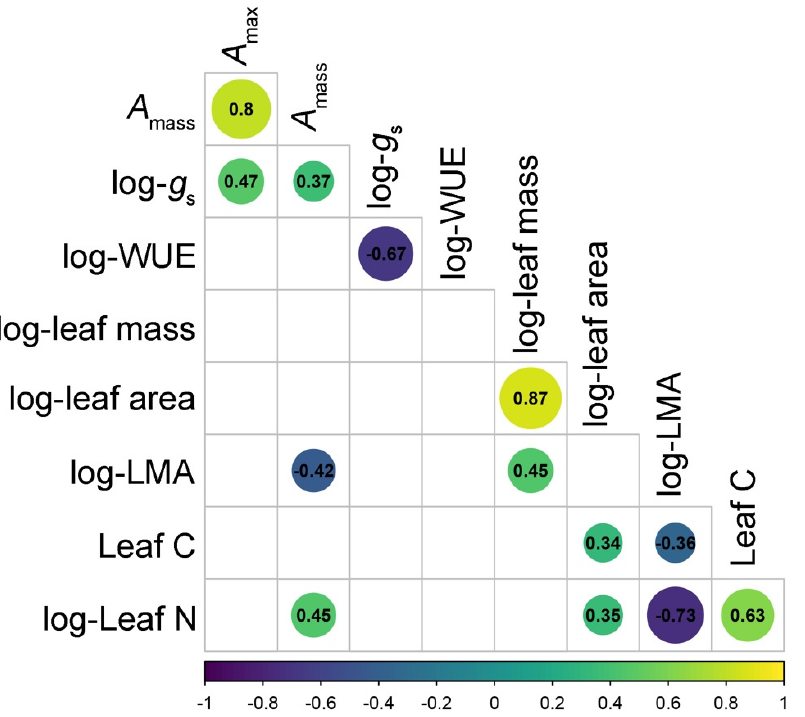
Figure 3. Pearson correlation tests analyzing the relationships between nine leaf traits measured across five wine grape varieties in Southern Ontario, Canada. Shades of circles correspond to Pearson correlation coefficients for each test which are presented numerically within the circles. Sample sizes for each correlation test were n = 90 leaves, and only statistically significant trait correlations represented by circles/correlation coefficients (where p ≤ 0.05) are presented here. A full trait correlation matrix is presented in Table S1. Trait abbreviations are as follows: A max : light saturated maximum photosynthetic rate on a per-unit leaf area basis; A mass : light saturated maximum photosynthetic rate on a per-unit leaf mass basis; g s : stomatal conductance; WUE: instantaneous water use efficiency; LMA: leaf mass per unit area.